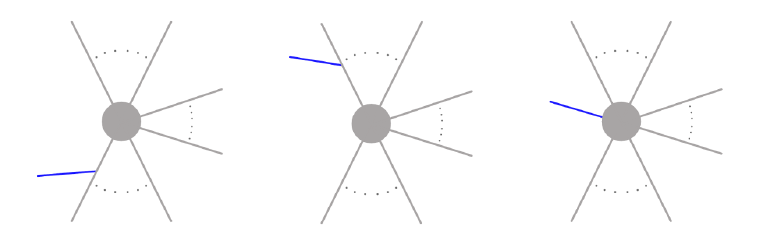
Figure 3 . Contributions to soft higher-spin emission amplitude where the emitting particle is a complex-valued higher-spin field